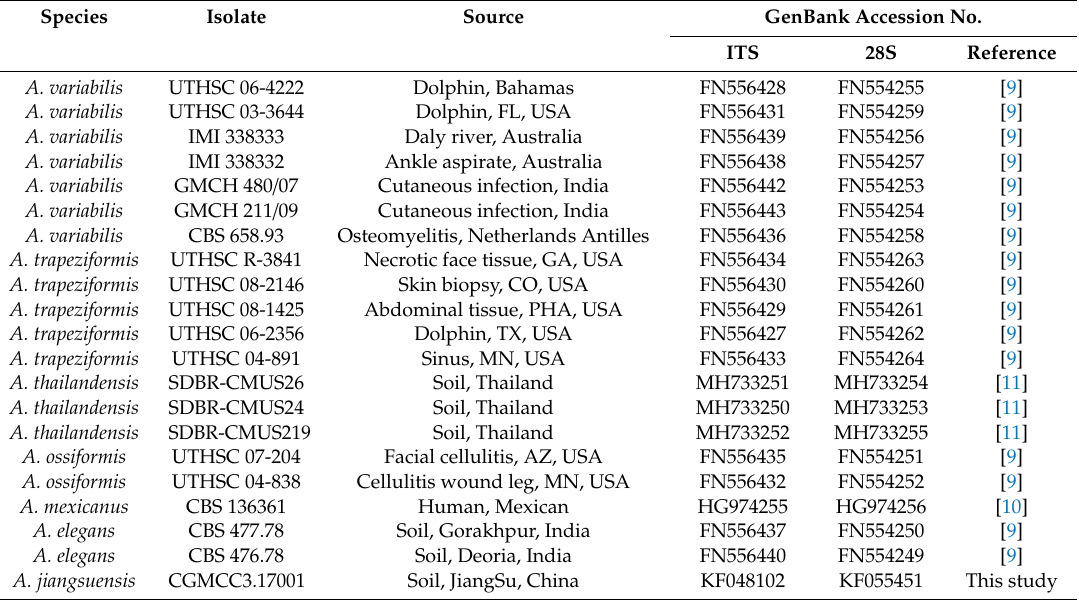
Table 1. The strains used in this study and their GenBank accession numbers. Species Isolate